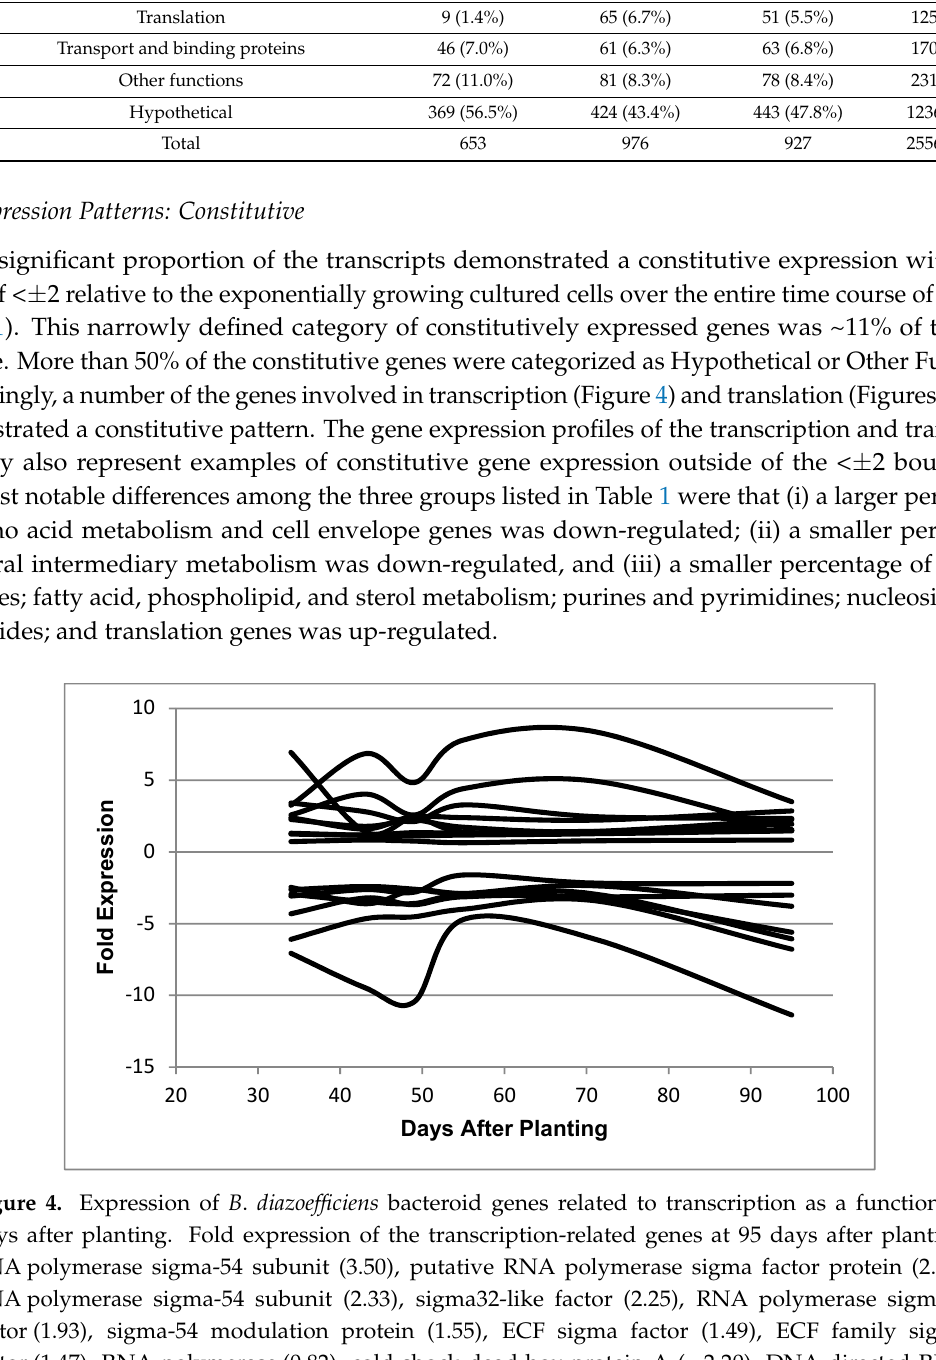
Figure 5. Expression of B . diazoefficiens bacteroid 30S ribosomal proteins as a function of days after planting. Fold expression value of 30S ribosomal proteins at 95 days after planting: S16 (0.36), S2 (0.29), S20 (0.27), S4 (0.20), S13 (0.19), S12 ( − 2.85), S19 (4.02), S6 ( − 4.43), S8 ( − 5.41), S14 ( − 5.60), S18 ( − 7.27), S7 ( − 7.61), S11 ( − 7.74), S1 ( − 9.46), S15 ( − 10.24), S3 ( − 17.81), S21 ( − 20.02), S10 ( − 21.90), and S17 ( − 24.51).